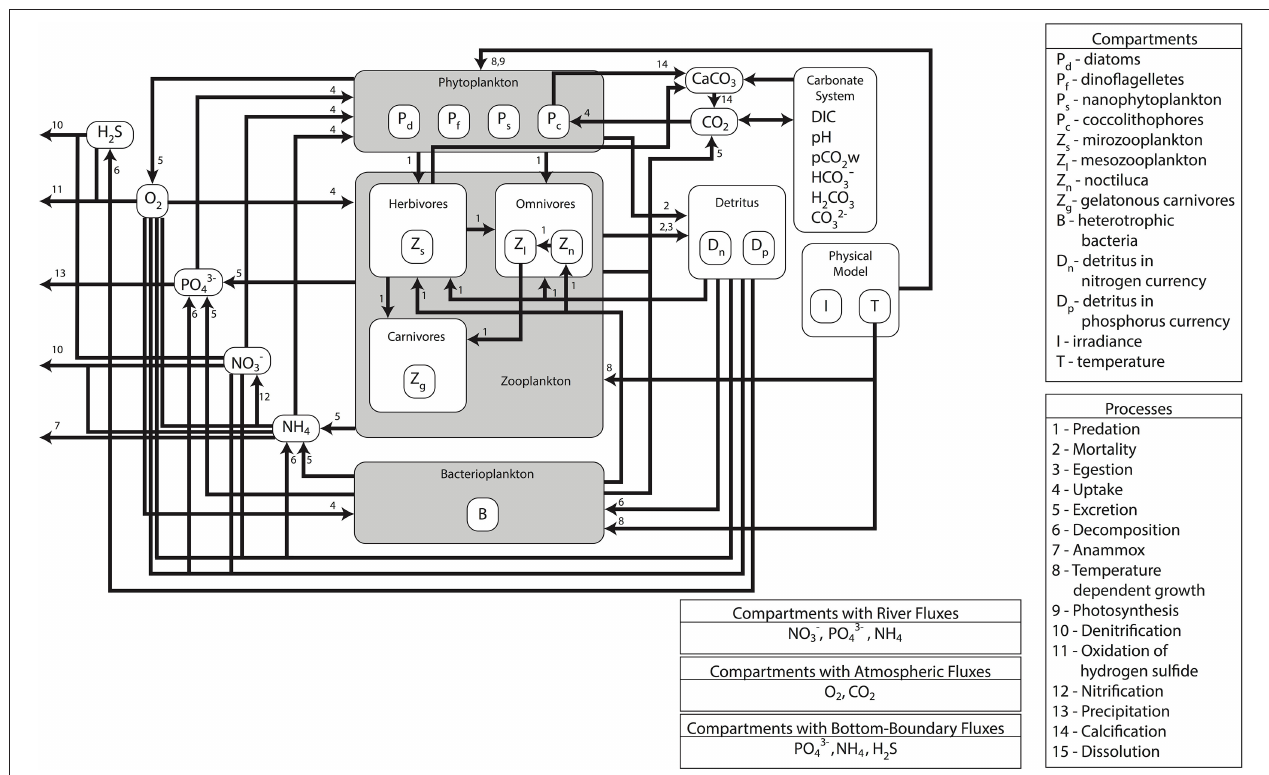
FIGURE 1 | Schematic of the lower trophic level model setup and trophic interactions used in the study. The model includes four phytoplankton groups, three zooplankton groups, two detritus groups, bacterioplankton and nutrients (NO 3 , NH 4 , PO 4 ) and a detailed representation of the carbonate